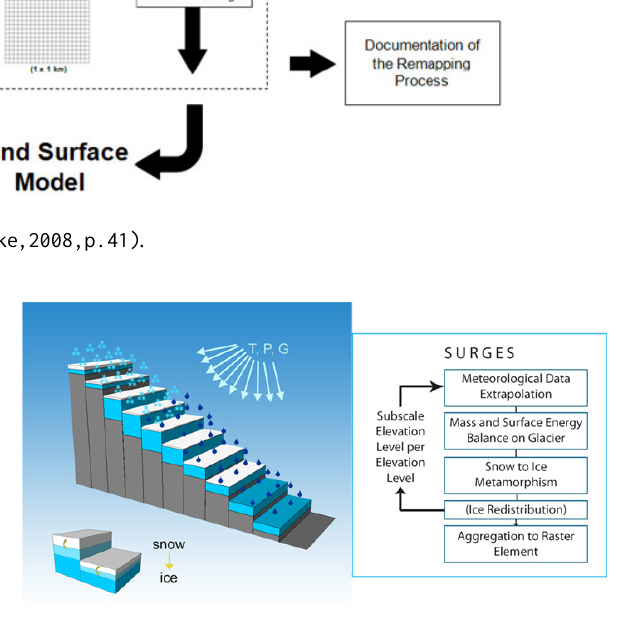
Figure 3. Scheme of the glacier model SURGES, symbolizing the subscale elevation levels of the glacierized area (Weber et al., 2009,